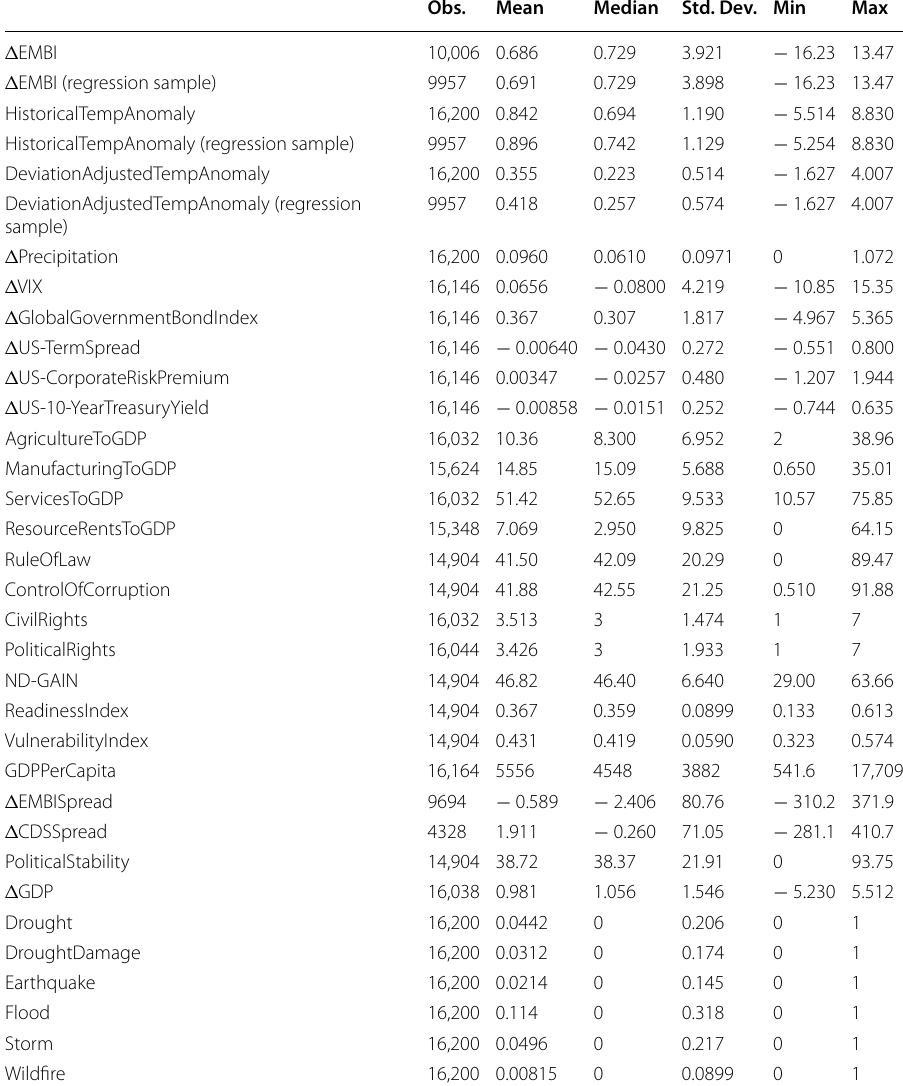
Table 3 Summary statistics of all